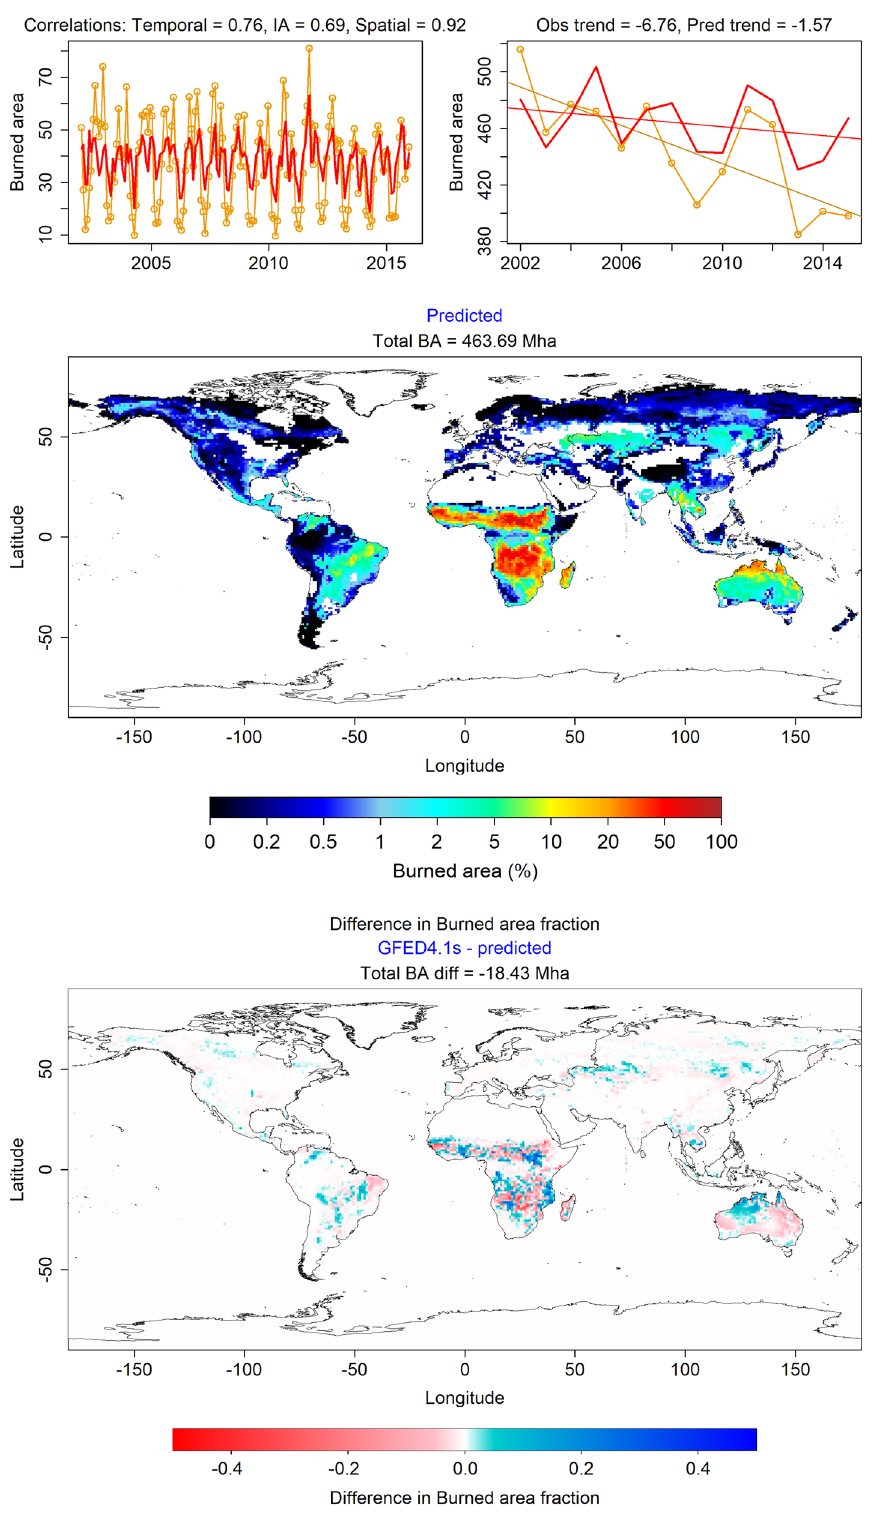
Figure 2. Spatio-temporal performance of our model at the global scale. Temporal monthly ( A ), annual ( B ), and spatial ( C ) burned area predicted by our model (solid red lines) compared with the GFED4.1s burned area data (orange lines and circles). Our model accurately predicts the spatial distribution of fires across the globe, with a spatial correlation of 0.92. It captures the yearly anomalies in global burned area reasonably well (with temporal correlation of 0.76 and interannual correlation of 0.69), and predicts a long term decline of 1.57 Mha/ year 2 during the years 2002–2015, compared to an observed decline of 6.76 Mha/ year 2